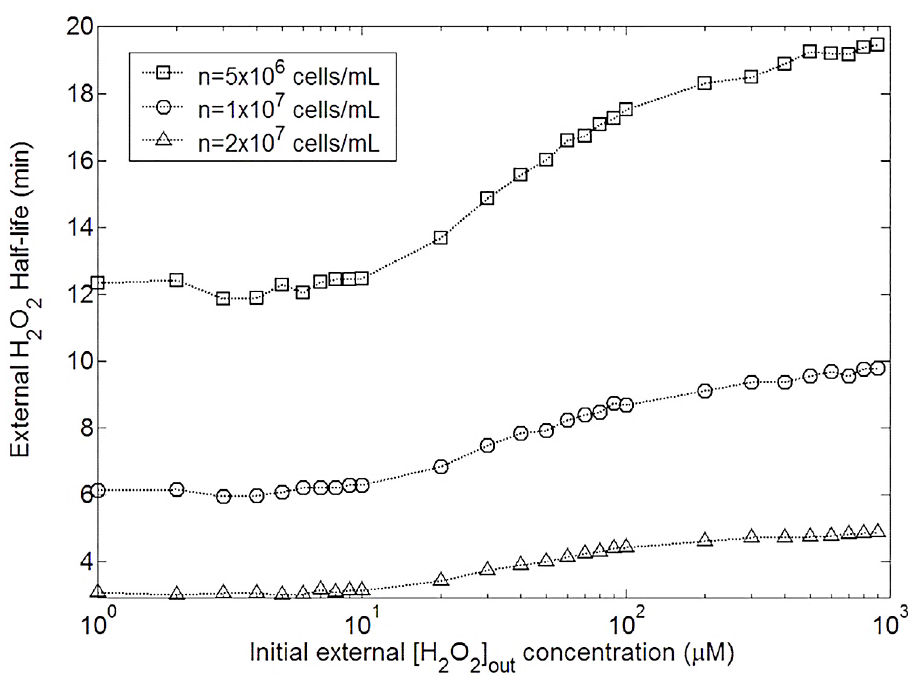
Fig 12. Changes in external H 2 O 2 half-life with different initial external H 2 O 2 concentrations and 3 different cell densities in E. coli wild type. The numerical solution presented in this graph was running according to the whole model without